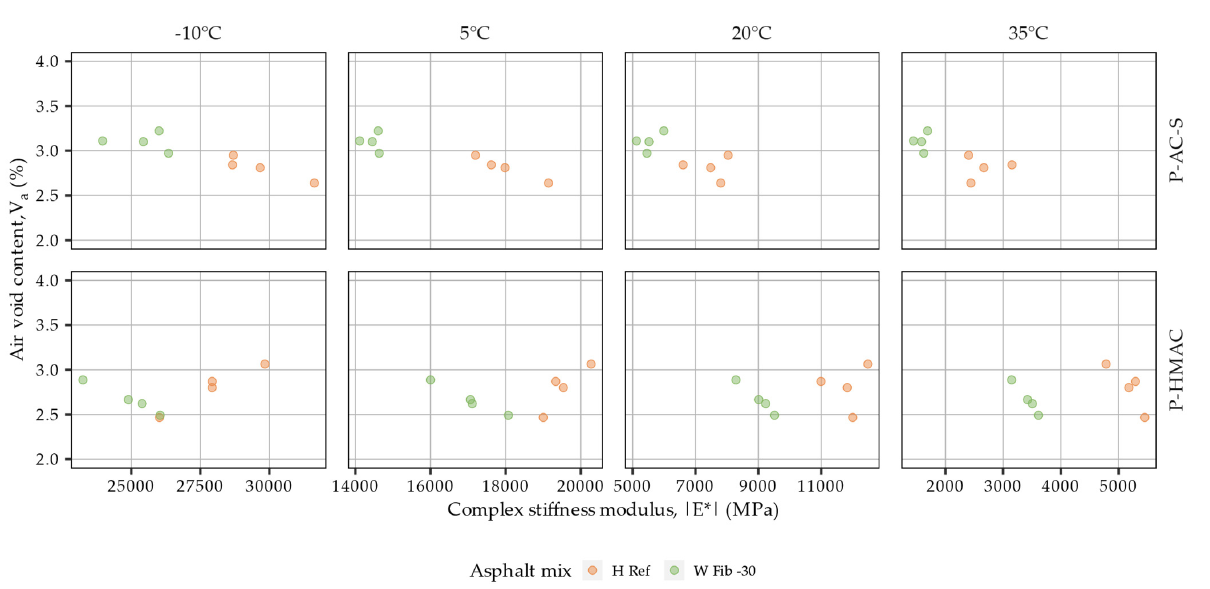
Figure 9. Measured versus predicted values of complex stiffness moduli in samples from plant pro- duced mixtures: Surface course mixtures ( a ), high modulus asphalt concrete mixtures ( b ). The relationships between the air void content of the samples from plant produced mixtures and their complex stiffness moduli are investigated in Figure 10. The air void contents of all tested samples ranged from 2.5% to 3.2%, and the largest difference be- tween the means in the respective mixtures amounted to 0.4%, which considering the dif- ferences in the dynamic moduli can be viewed as minute. The analysis of variance in fact did not confirm the effect of air void content to be a significant factor affecting the dynamic moduli of the plant produced mixtures (p-value > 0.05).